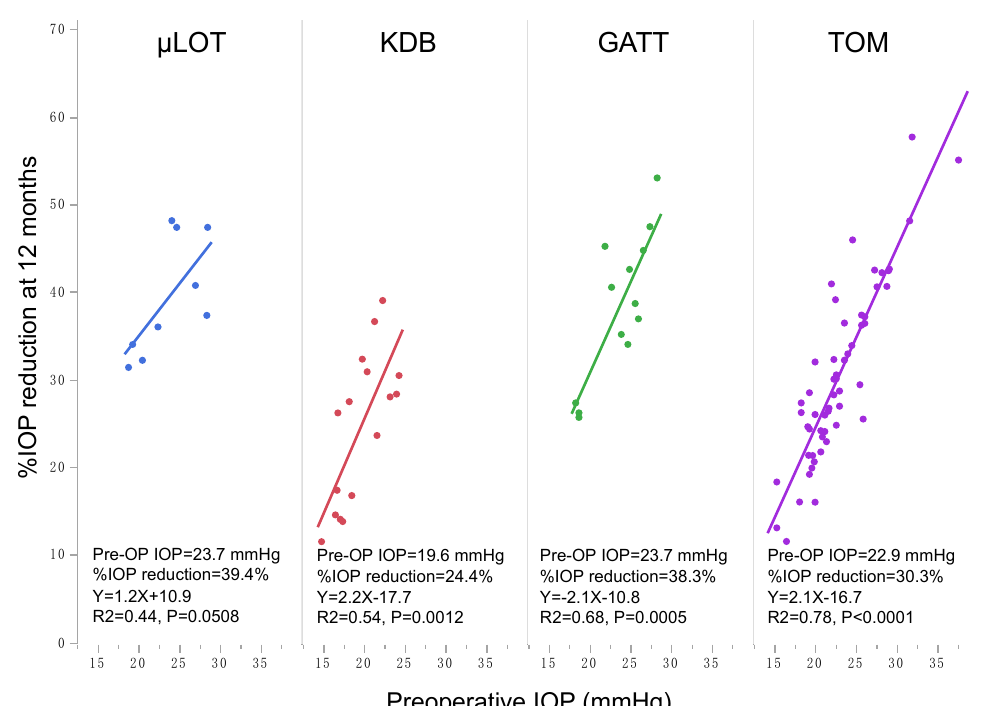
Figure 3. Correlation between preoperative and postoperative 12 months IOP after each ab interno goniotomy procedure in the published literature. Each line and area indicate linear regression and 95% confidence intervals, respectively. µLOT, microhook trabeculotomy; KDB, Kahook dual blade; GATT, gonioscopy-assisted transluminal trabeculotomy; TOM, Trabectome.